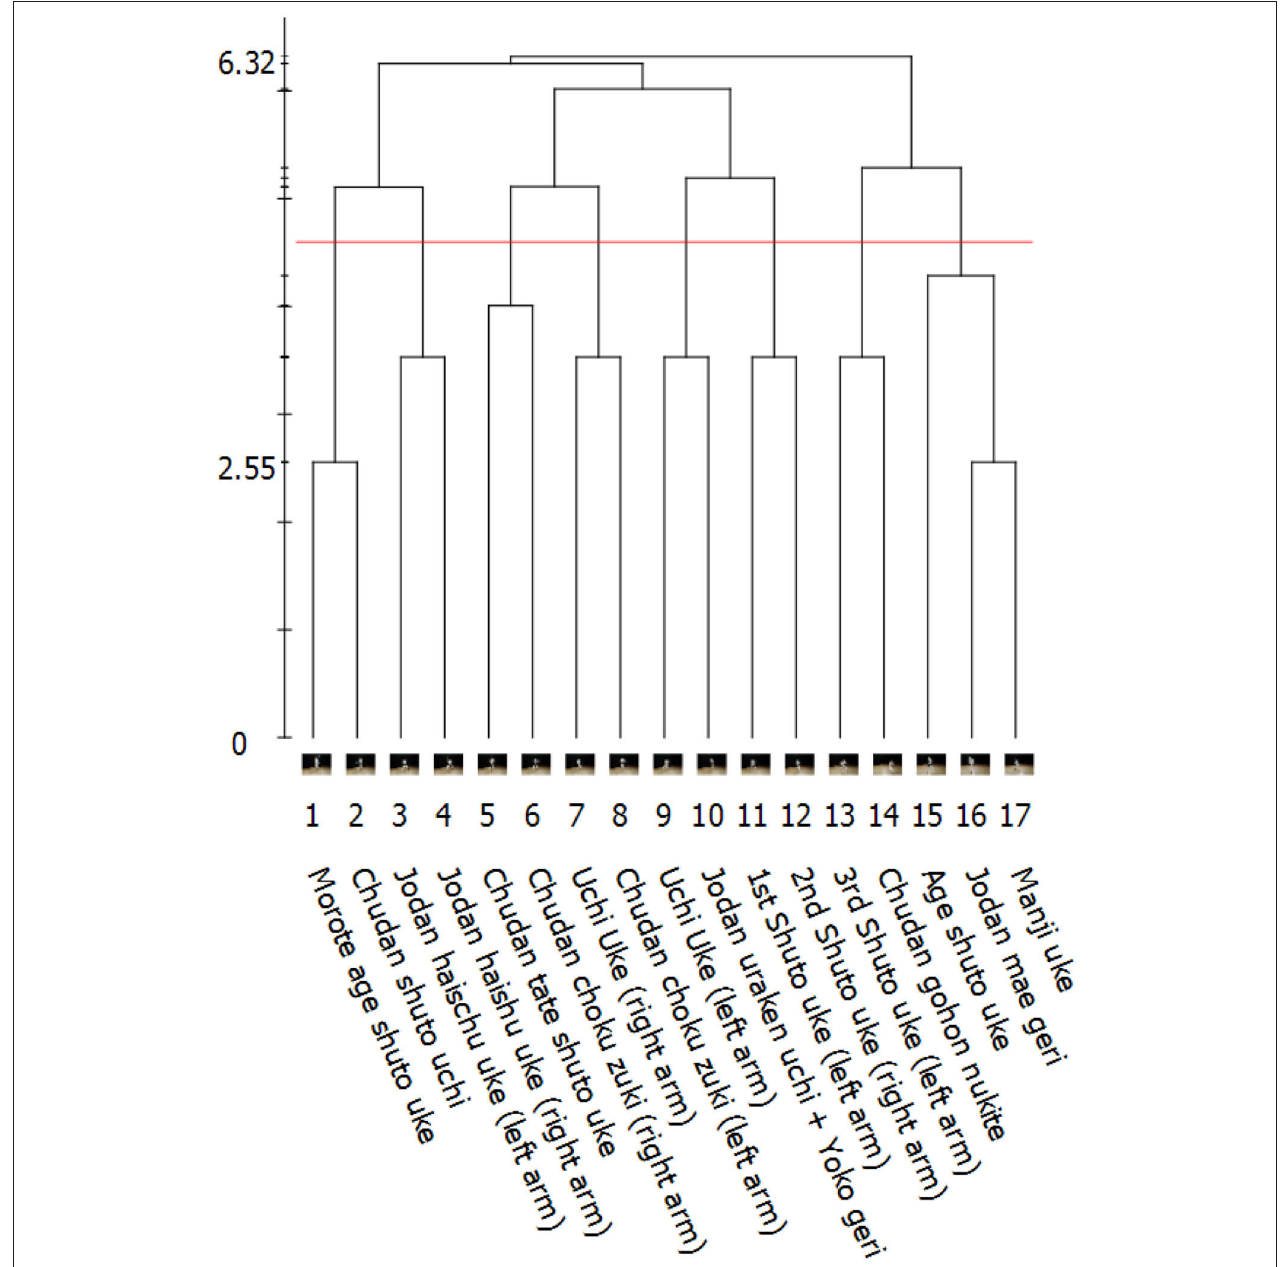
FIGURE 3 | Visualization of a 2nd dan (black belt) karate practitioner’s individual mental representation structure related to the Kanku-dai movement sequence by an SDA-M dendrogram. Numbers below the dendrogram indicate designated positions of each action within the sequence.